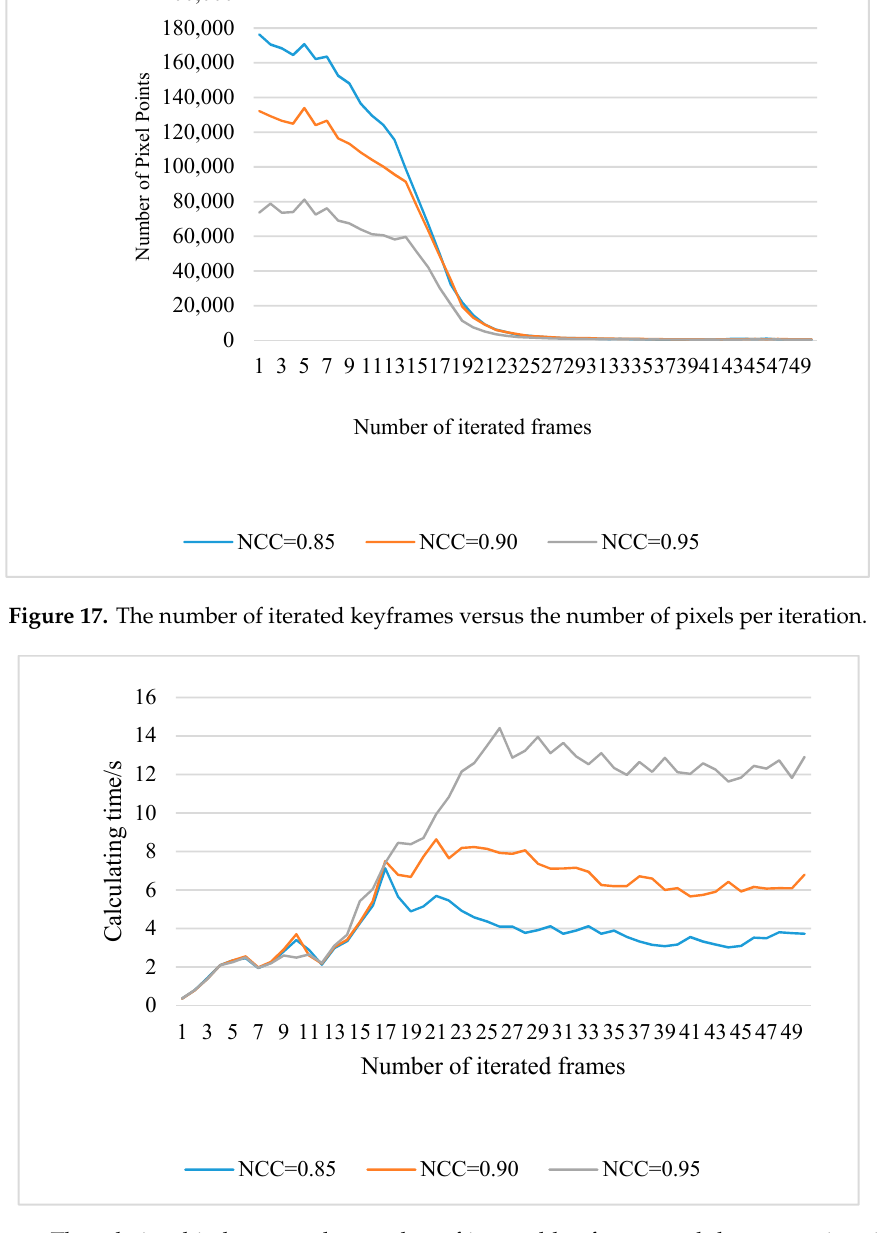
Figure 18. The relationship between the number of iterated keyframes and the computing time of each iteration.